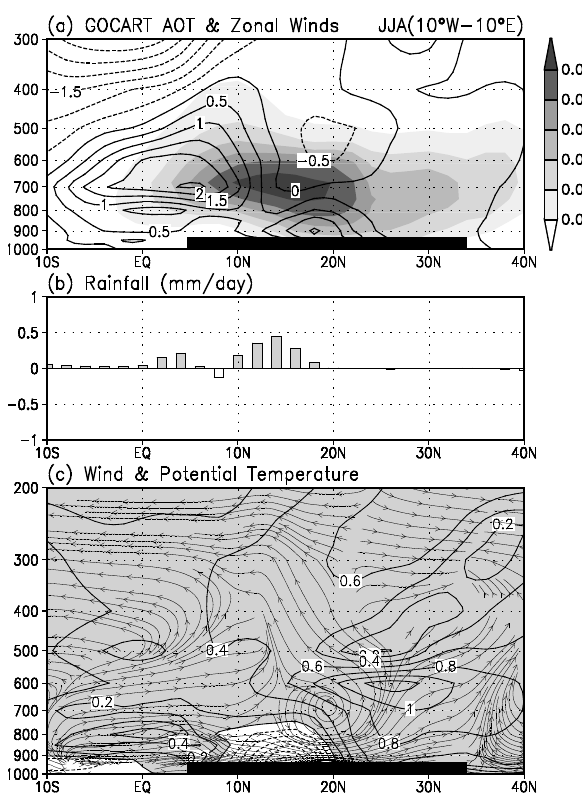
Fig. 7. Vertical meridional cross-sections averaged over the West Africa/eastern tropical Atlantic region (10 ◦ W–10 ◦ E) of JJA dust induced anomalies in (a) zonal wind (contour in ms − 1 ) and GO- CART aerosol optical thickness (shading, non-dimensional unit), (b) rainfall anomaly (mmday − 1 ) and (c) meridional and vertical wind streamline and potential temperature (contour in ◦ C).